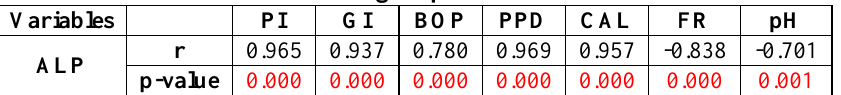
Table 8: Pearson’s Correlation Coefficient (r) between Clinical Periodontal Parameters (PLI, GI, BOP, PPD, CAL) and biochemical parameters (ALP) with salivary flow rate of thesevere